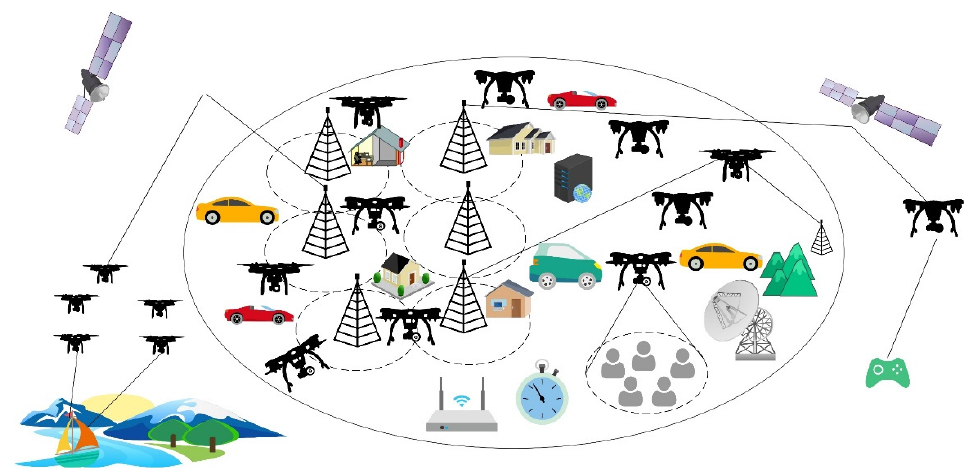
Figure 13. The General Scenario of UAV